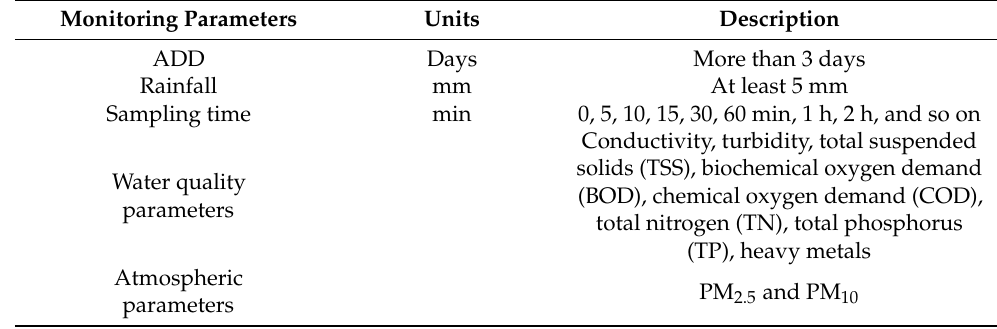
Table 2. Monitoring